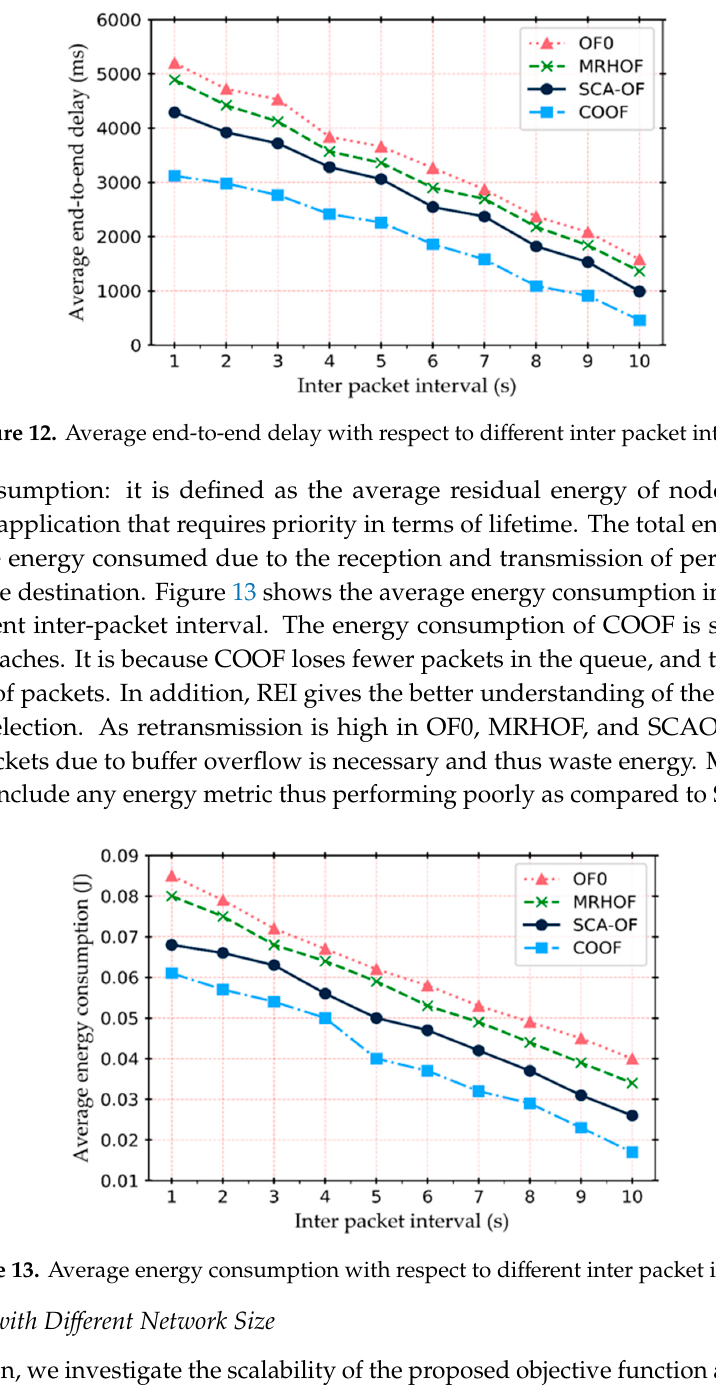
19 of 26 Figure 11. Packet losses in the queue; ( a ) packet loss ratio in terms of different inter packet arrival interval, ( b ) packet loss ratio with respect to the transmit and receive success ratio. Average end-to-end delay: It represents the average time difference between the time when the data packet was sent and the time when the data packet was received at the root node. The average end-to-end delay has been evaluated under different inter-packet interval, as shown in Figure 12. The result shows that, as compared to other, COOF achieves the lowest packet delivery delay. The average delay in OF0 is significantly greater than MRHOF, SCAOF, and COOF. It was obvious,